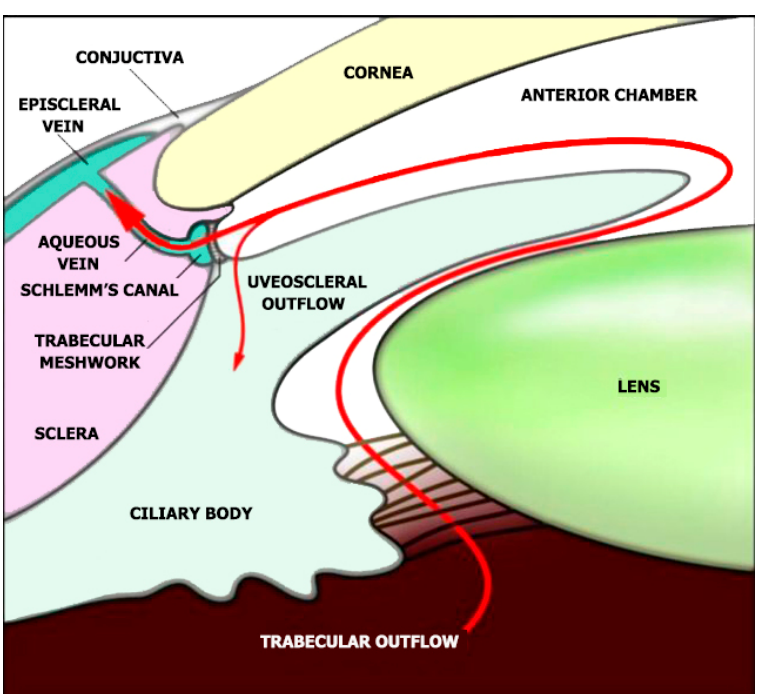
Figure 1. Aqueous humor indicated as the red line is produced by the ciliary body. The aqueous humor flows to the anterior chamber and leaves through the trabecular meshwork and Schlemm’s canal, then into the episcleral veins. The injection of nanoparticles is done through the anterior chamber and is perceived to follow the normal trabecular drainage pathway. Reproduced from ref [15,16] with permission from WILEY-VCH Verlag GmbH and Co. KGaA,